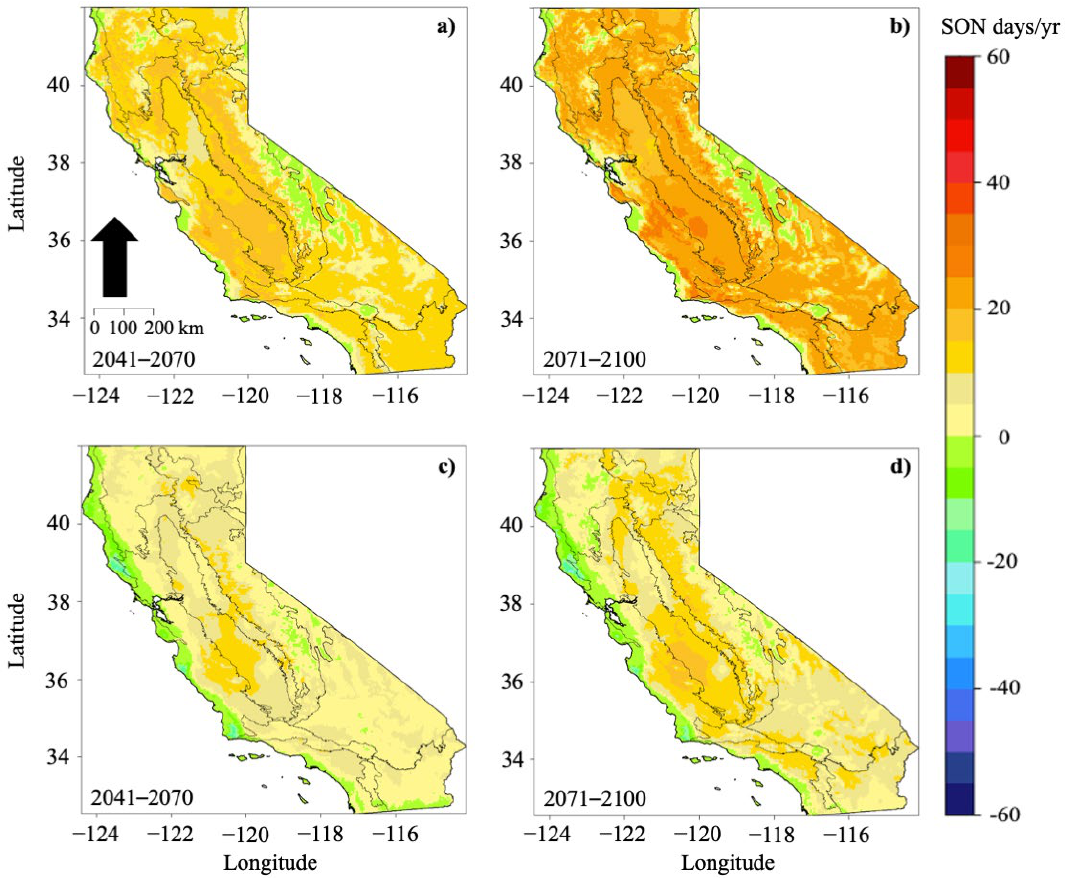
Figure 7. Average frequency (in days/yr) with which VPD and FWI exceed the ecoregion specific daily average SON 95th percentile in the mid-century ( left ) and late-century ( right ) relative to the historic period. Higher values indicate more SON days that exceeded the 95th percentile. ( a , b ) Vapor pressure deficit ( c , d ) Fire Weather Index.